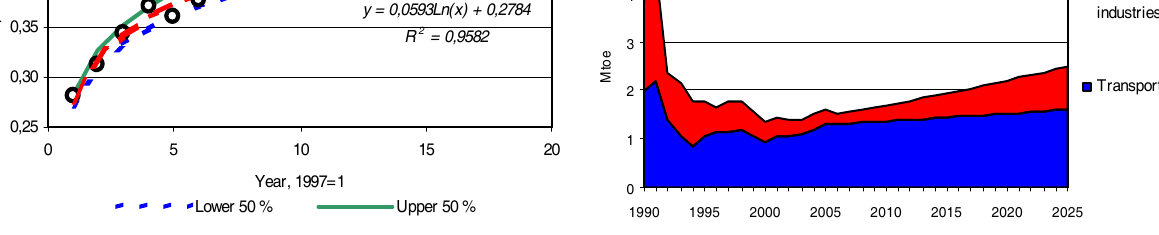
Fig 11. Dynamic function of the number of transport means per capita in Lithuania